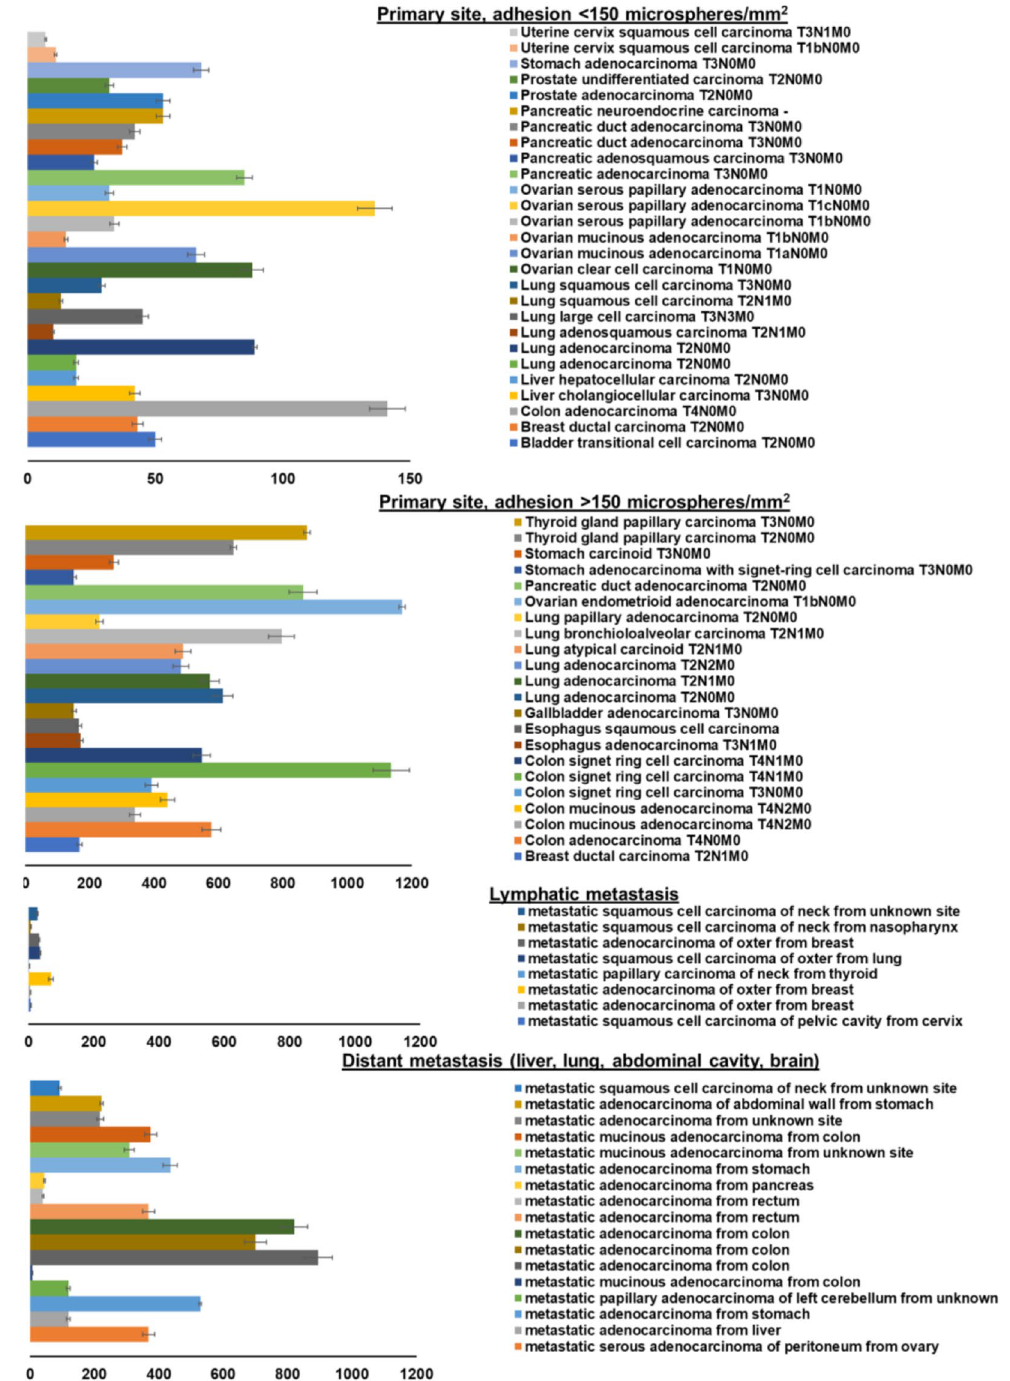
Figure 8. DBTA detects functional selectin ligands expressed on tissue from multiple solid tumors at both primary and metastatic sites. mE-selectin DBTA probes adhesion to cancerous tissues derived from primary and metastatic sites. DBTA probes were perfused at 500,000 probes/mL and 0.50 dyne/cm 2 . Data shown are mean adhesion per mm 2 ± SD of three technical replicates and include the deduction of control probe adhesion (viz. mean of P-selectin adhesion minus the greater mean value of either P-selectin + EDTA or IgG control